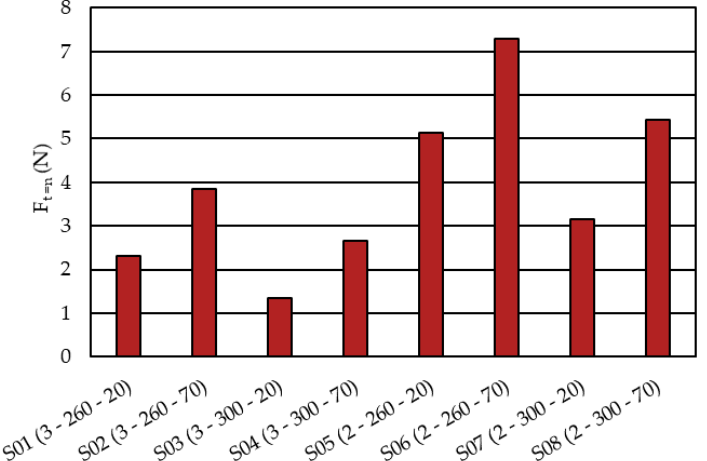
Figure 11. Simulated F t=n forces for the parameter study defined in Table 3. The numbering in brackets reads (mold thickness (mm)–melt temperature ( ◦ C)–injection speed (cm 3 /s)). (A), the higher the melt temperature (B), and the slower the injection speed (C).